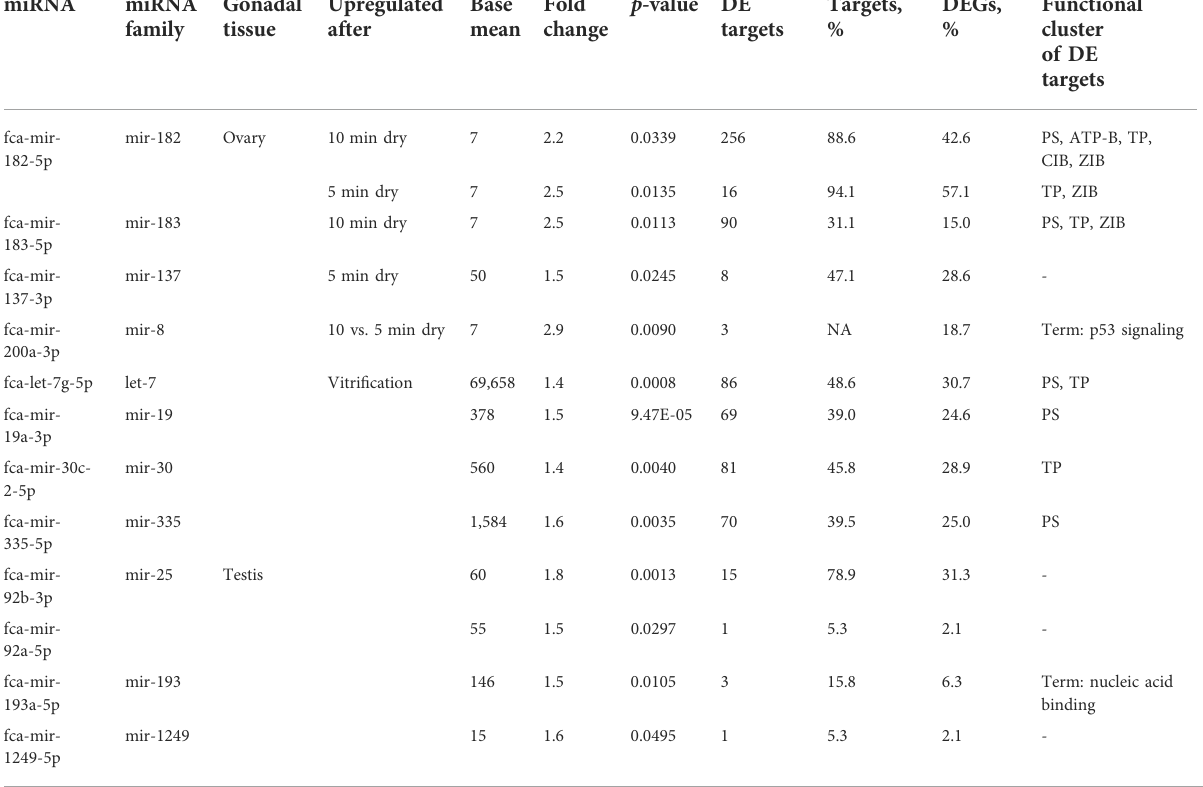
TABLE 3 Impact of upregulated miRNAs on downregulated mRNAs after drying or vitri fi cation of gonadal tissue.